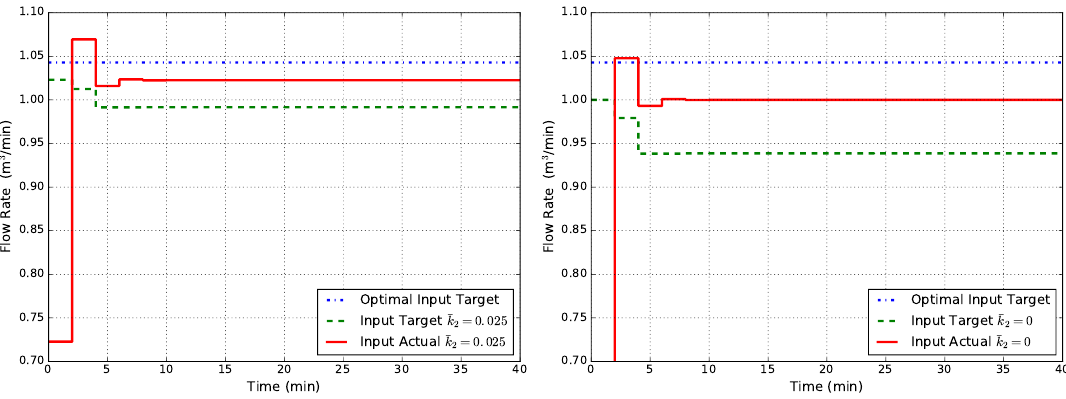
Figure 3. Closed-loop flow rate Q obtained with EMPC1 (state disturbance model) for two cases of uncertainty in k 2 : ¯ k 2 = 0.025 ( left ) and ¯ k 2 = 0 ( right ).